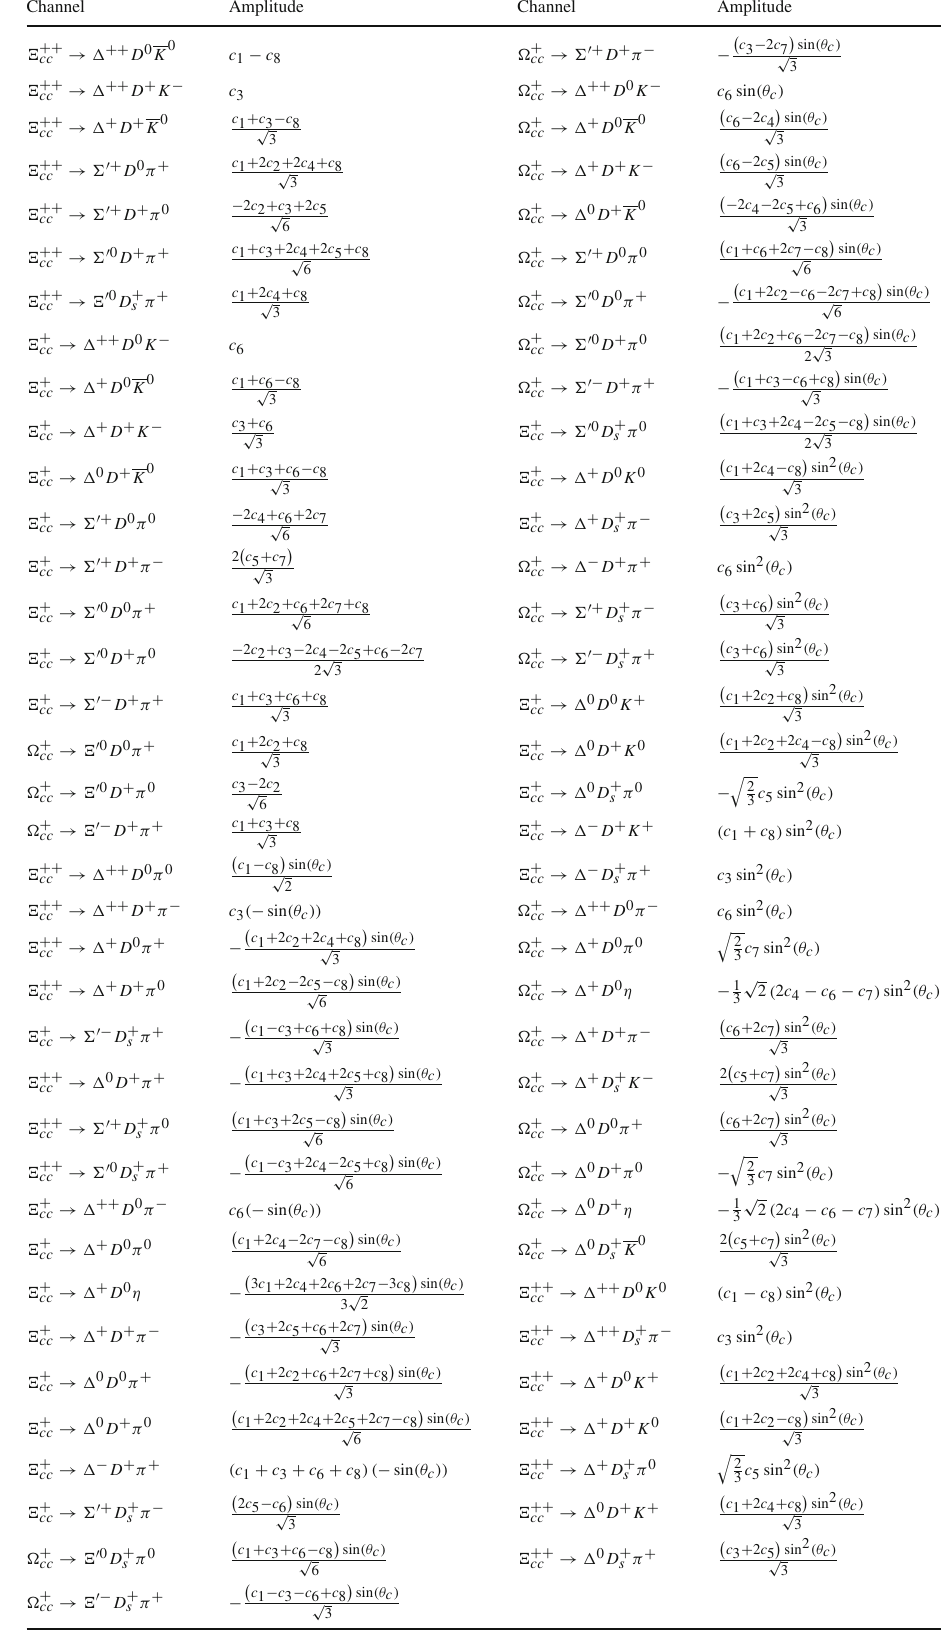
Channel Amplitude Channel